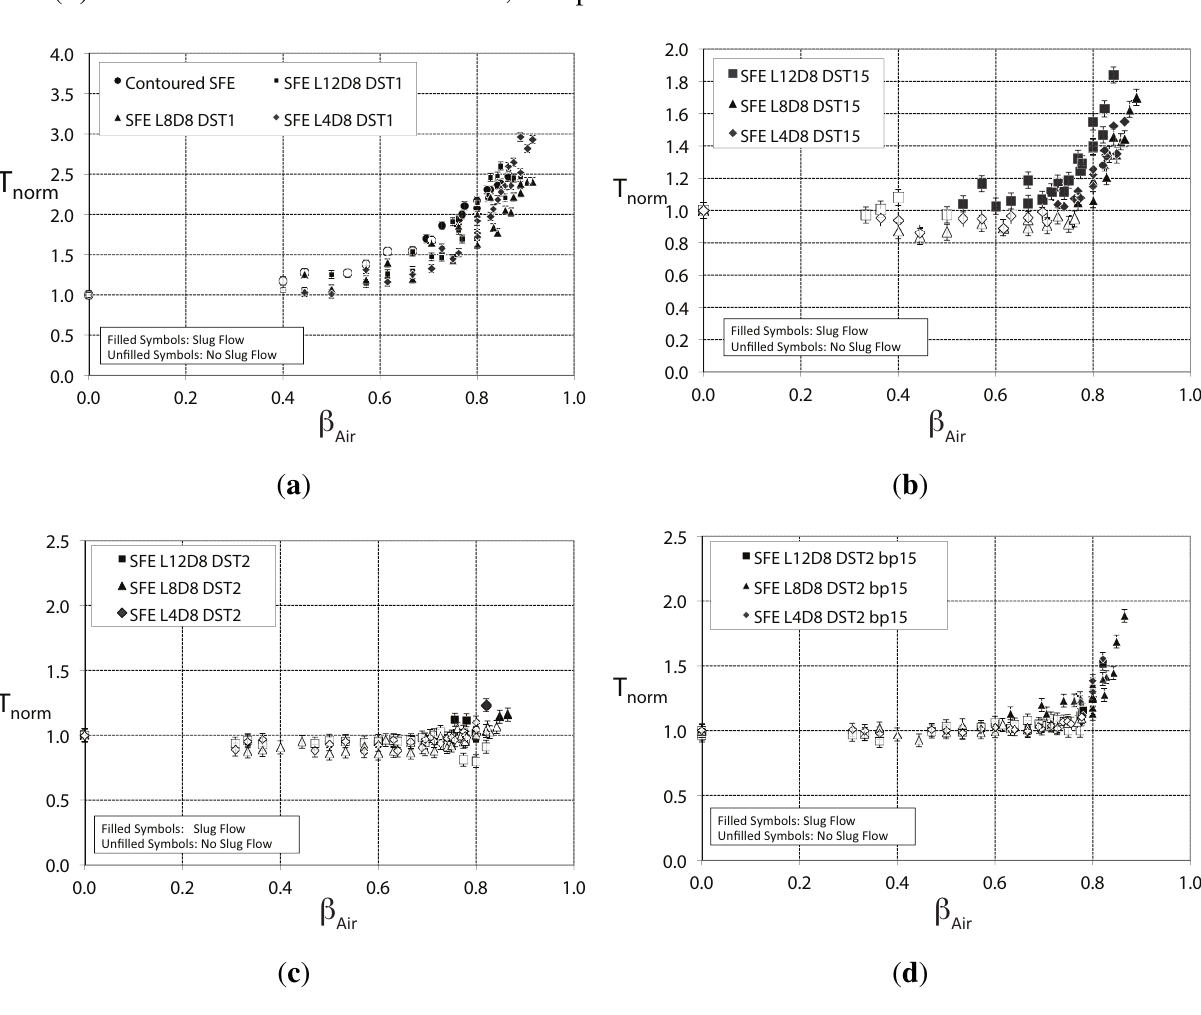
Figure 12. Summary of thrust measurements ( a ) downstream tube diameter 25 mm; ( b ) downstream tube diameter 38 mm; ( c ) downstream tube diameter 51 mm; ( d ) downstream tube diameter 51 mm, backpressure